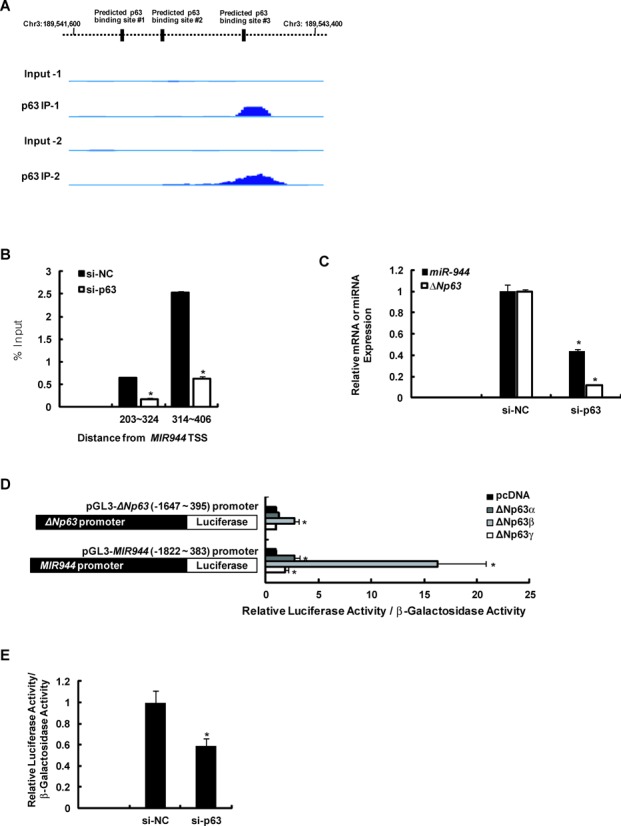
ΔNp63 is responsible for the activation of the MIR944 promoter. (A) ChIP-seq results obtained from GEO (accession number GSE32061) for the MIR944 promoter for two independent biological replicates. (B) ChIP-qPCR results for ΔNp63 binding to the MIR944 promoter in keratinocytes that had been transfected with the si-NC compared to those transfected with TP63 siRNA (si-p63). Data represent the means ± SD of triplicate biological samples and are representative of three different experiments. *P < 0.05 versus si-NC, unpaired Student's t-test. (C) Reduction in miR-944 expression with p63 depletion in keratinocytes. Keratinocytes were transfected with 50 nM siRNA against TP63 mRNA (si-p63) or si-NC. After 2 days, RNA was extracted, and expression levels were analyzed using RT-qPCR. The levels of ΔNp63 mRNA were normalized to the expression of RPLP0, and those of miR-944 were normalized to levels of RNU48 small RNA. Data represent the means ± SD of triplicate biological samples and are representative of three different experiments. *P < 0.05 versus si-NC, unpaired Student's t-test. (D) WM266-4 melanoma cells, which do not express ΔNp63 and miR-944, were transfected with the ΔNp63 promoter-luciferase or the MIR944 promoter-luciferase construct in combination with the pcDNA (mock vector), ΔNp63α, ΔNp63β or ΔNp63γ expression vectors. After 1 day of incubation, luciferase and β-galactosidase activities were measured. Luciferase activities were normalized to β-galactosidase activities. Data represent the means ± SD of triplicate biological samples and are representative of three different experiments. *P < 0.05 versus pcDNA, unpaired Student's t-test. (E) Keratinocytes were transfected with 50 nM siRNA against TP63 mRNA (si-p63) or si-NC. After 1 day, the keratinocytes were transfected with the MIR944 promoter-luciferase construct. After 2 days of incubation, keratinocytes were lysed, and the luciferase and β-galactosidase activities were measured. Luciferase activities were normalized to β-galactosidase activities. Data represent the means ± SD of triplicate biological samples and are representative of three different experiments. *P < 0.05 versus si-NC, unpaired Student's t-test. (F) UCSC Genome Browser view of the PhyloP score and the nucleotide alignment of multiple species for the predicted p63-binding sites on the MIR944 promoter region. In the bottom, the sequences of the wild type and the mutant type were shown. (G) Each of three predicted p63-binding sites was mutated by site-directed mutagenesis. WM266-4 melanoma cells were transfected with a wild type or mutant type MIR944 promoter-luciferase construct in combination with a pcDNA (mock vector), ΔNp63α, or ΔNp63β expression vector. After 1 day of incubation, the luciferase and β-galactosidase activities were measured. Luciferase activities were normalized to β-galactosidase activities. Data represent the means ± SD of triplicate biological samples and are representative of three different experiments. *P < 0.05 versus pcDNA, unpaired Student's t-test.